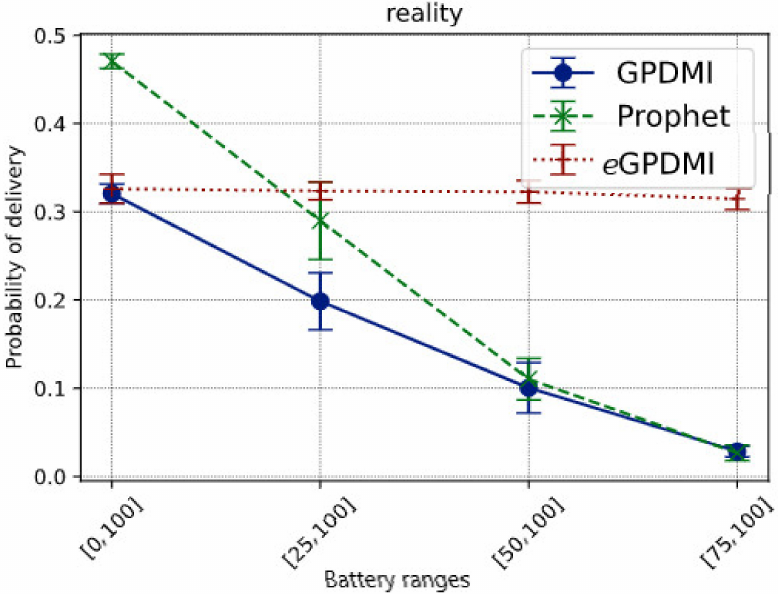
Figure 6. Impact of battery ranges on the delivery probability of messages in the Reality